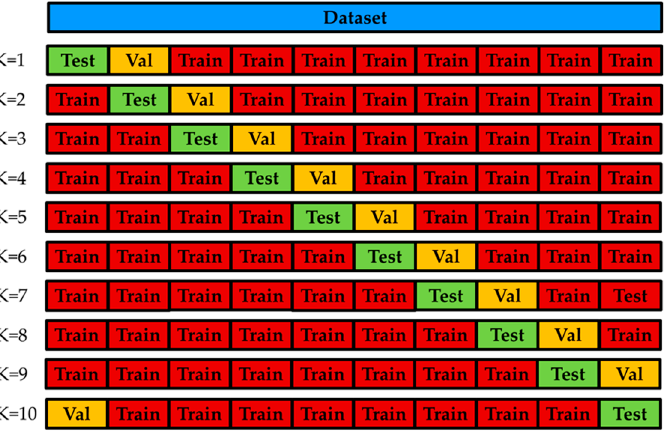
Figure 9. Round-robin strategy for 10-fold Subject-Wise cross-validation.